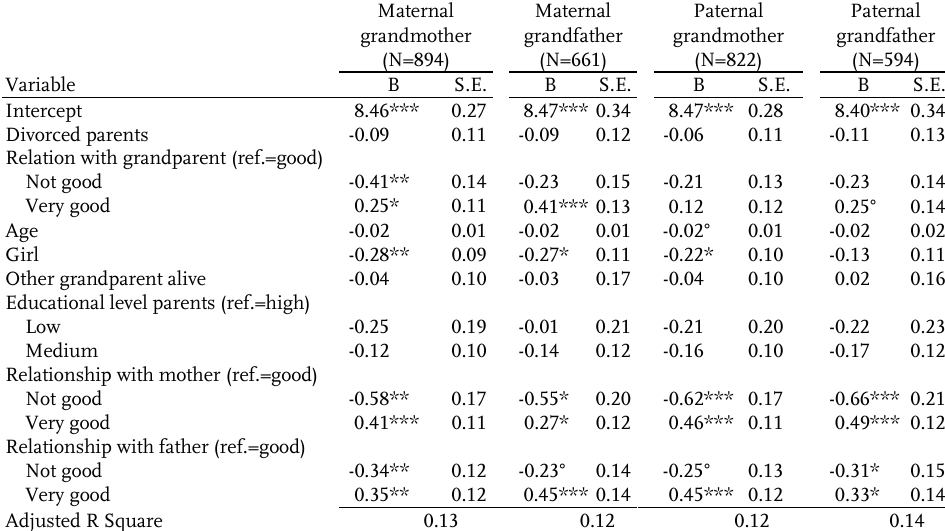
Table A.1 : Linear regression analyses of grandchildren’s life satisfaction, sample including grandchildren with divorced and married